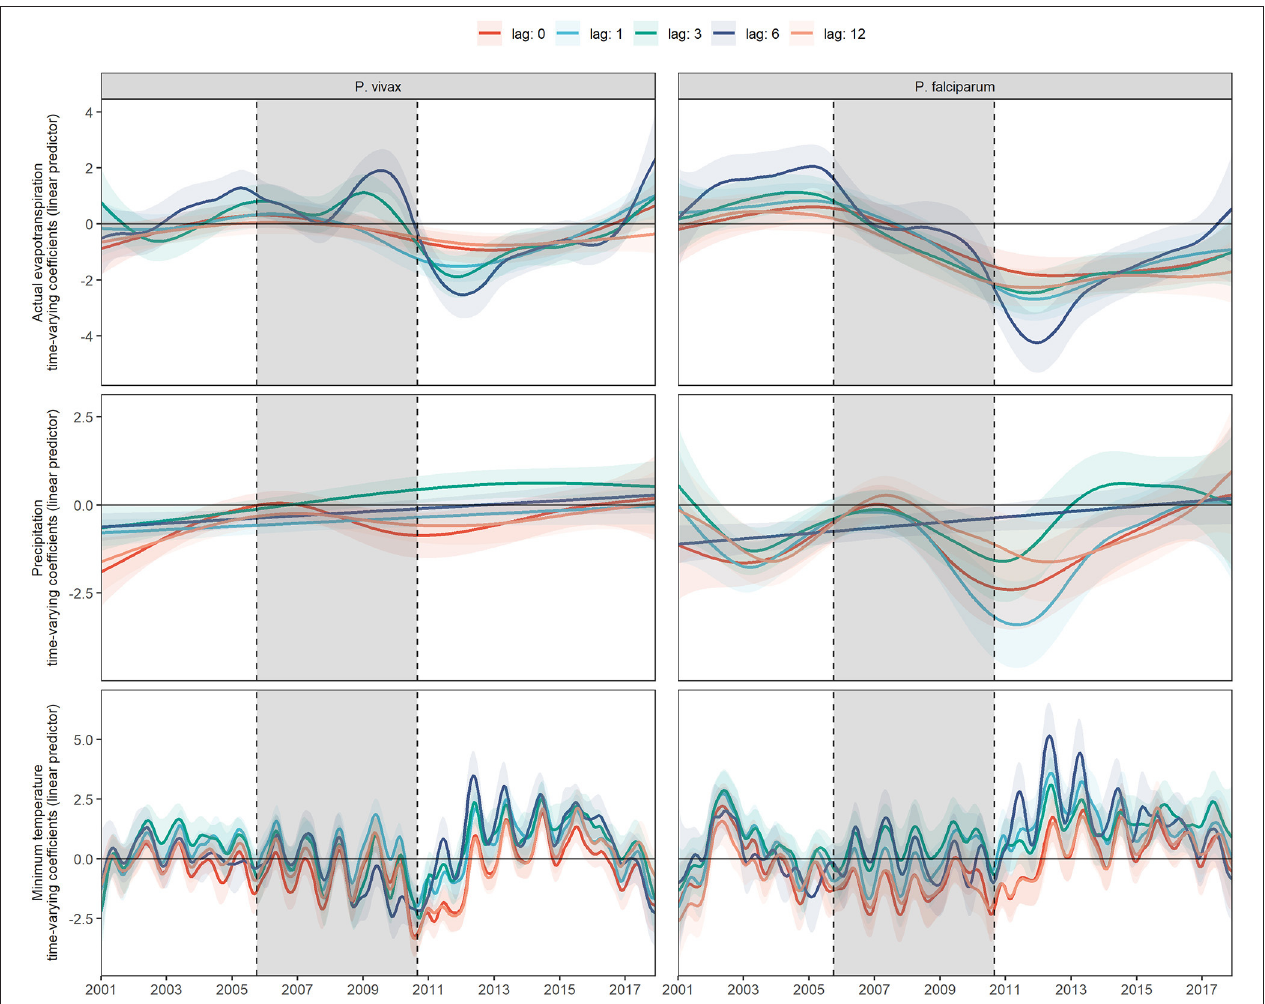
FIGURE 3 | Fitted time-varying meteorological effects on MIR by parasite species at different time lags. Fitted time-varying meteorological effects at different time lags and their 95% CI (shading of each colored curve). The period shaded in gray represents the PAMAFRO